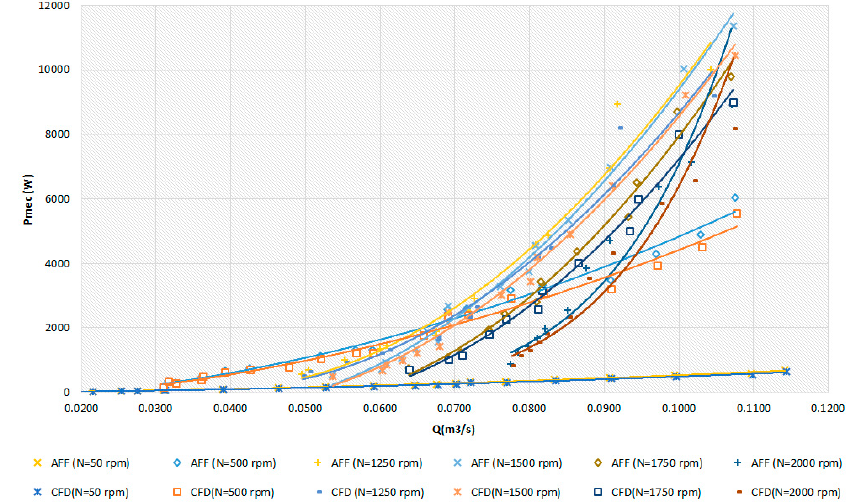
Figure 14. Comparison between mechanical power estimated by CFD and affinity model, for different rotational speeds ( D = 170 mm).